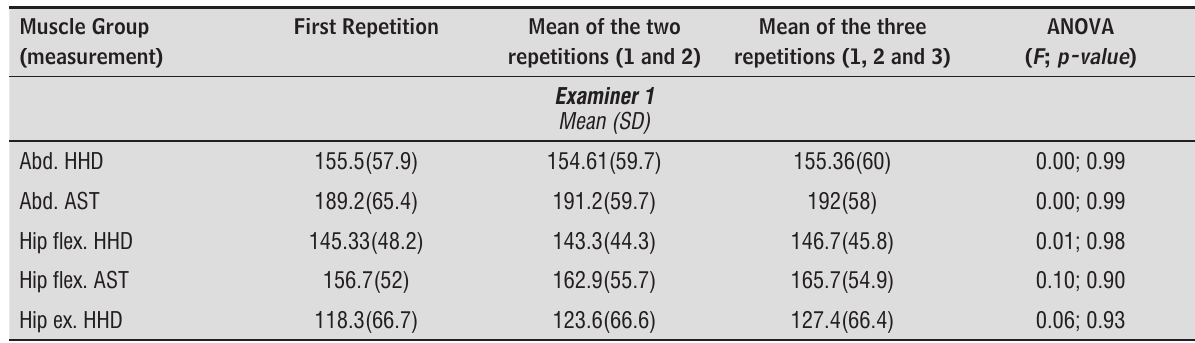
Table 2 - Descriptive data of muscle strength with different forms of measurement, AST (mmHg) and HHD (N), and results of the analysis of variance (ANOVA) among the three repetitions investigated, considering the first session and examin- ers 1 and 2, n =